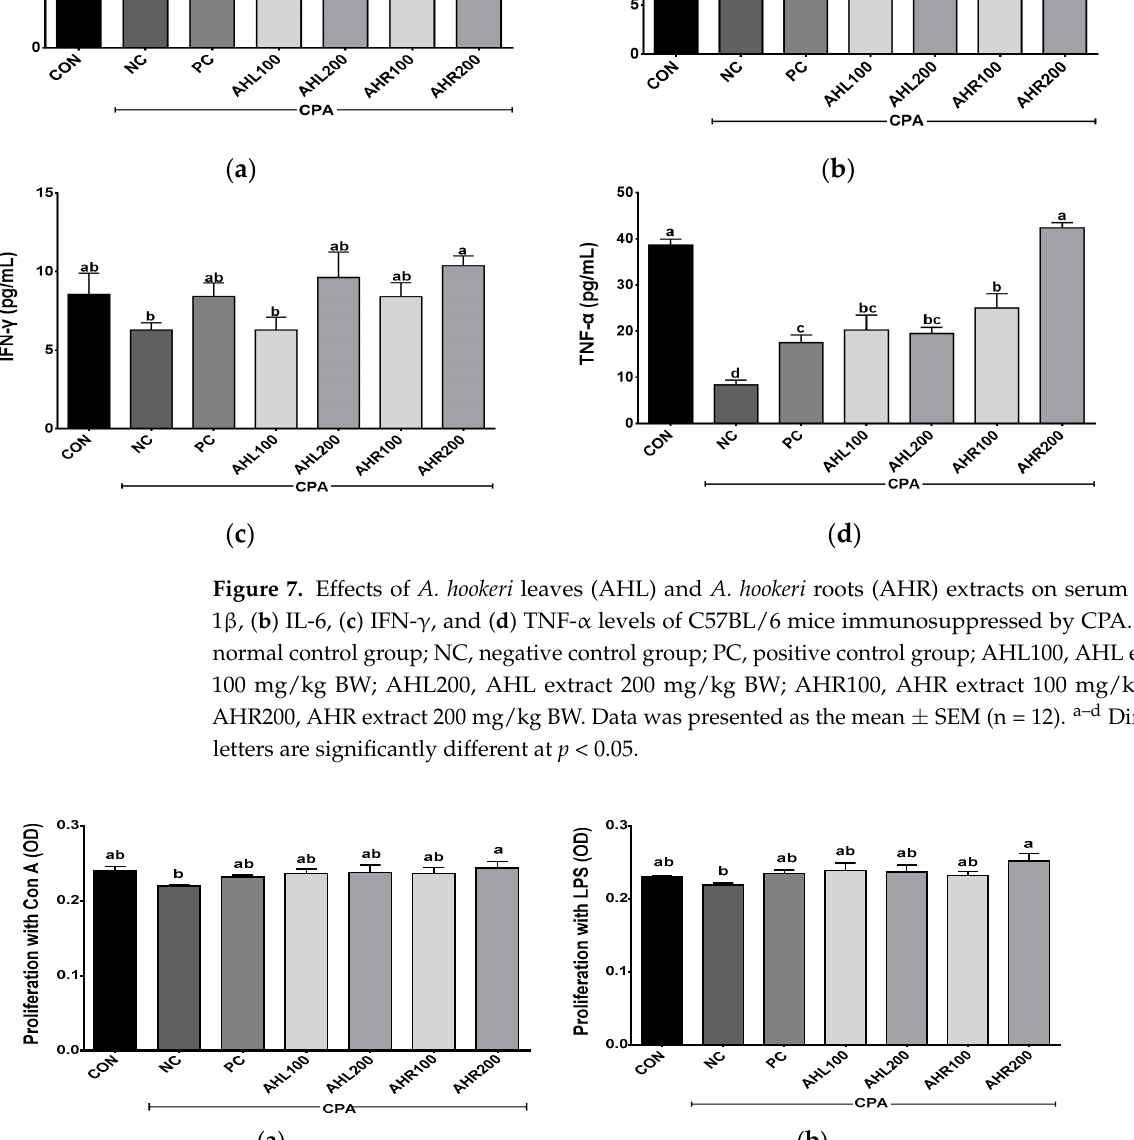
Figure 7. Effects of A. hookeri leaves (AHL) and A. hookeri roots (AHR) extracts on serum ( a ) IL-1 β , ( b ) IL-6, ( c ) IFN- γ , and ( d ) TNF- α levels of C57BL/6 mice immunosuppressed by CPA. CON, normal control group; NC, negative control group; PC, positive control group; AHL100, AHL extract 100 mg/kg BW; AHL200, AHL extract 200 mg/kg BW; AHR100, AHR extract 100 mg/kg BW; AHR200, AHR extract 200 mg/kg BW. Data was presented as the mean ± SEM (n = 12). a–d Different letters are significantly different at p < 0.05.